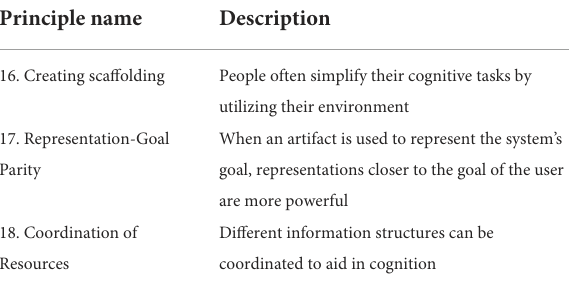
TABLE 1 The 18 principles of DiCoT analysis, summarized from Blandford and Furniss